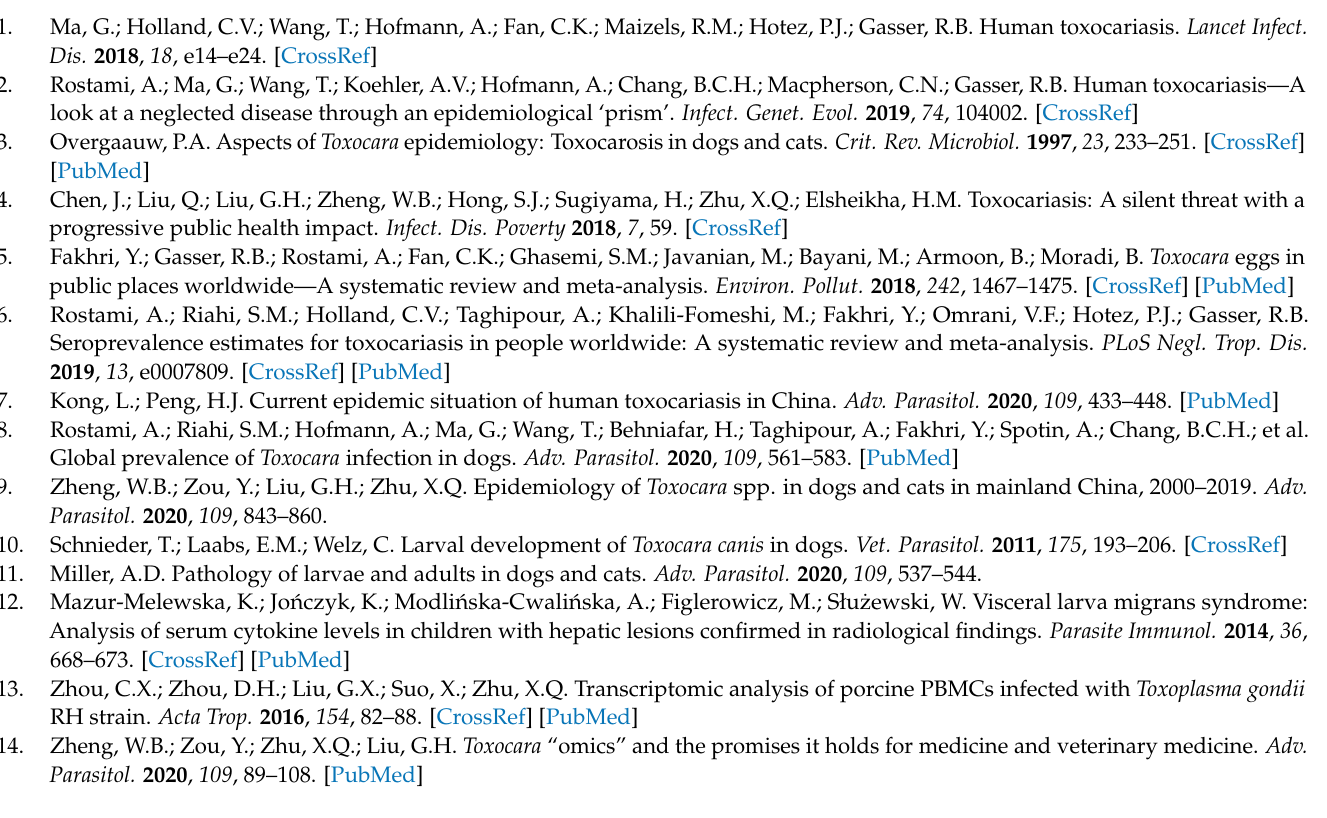
Table S2. The information fo the differentially expressed mRNA according to padj < 0.05. Table S3. The information for the differentially enriched GO terms according to p -value < 0.05. Table S4. The information for the differentially enriched KEGG terms according to p -value < 0.05. Figure S1. KEGG annotation pathway map of the upregulated ECM-receptor interaction signaling pathway. Boxes with red and green borders represent the upregulated differentially expressed mRNAs (DEmRNAs) and downregulated DEmRNAs. Boxes with yellow borders represents containing both upregulated and downregulated